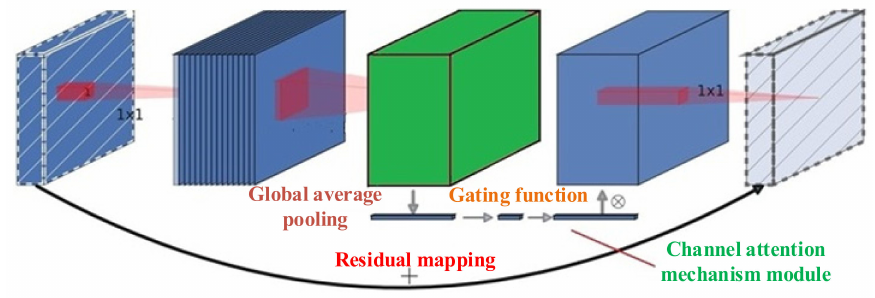
Figure 5. Inverted residual convolutional block.